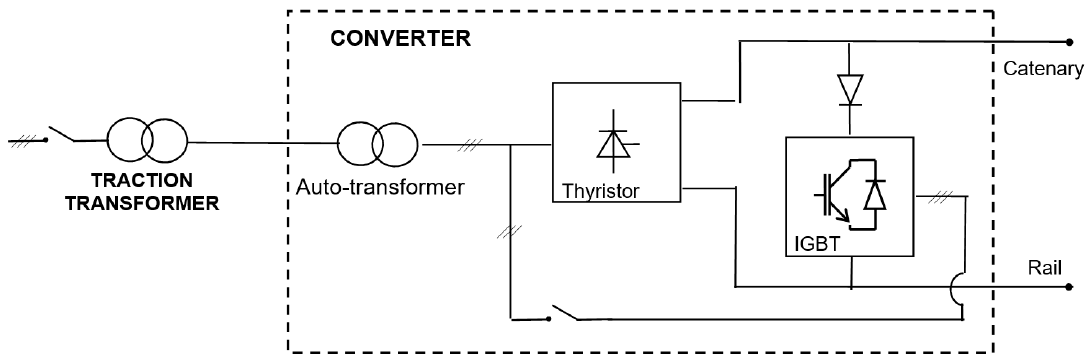
Figure 8. Structure of the active substation with direct return [117].